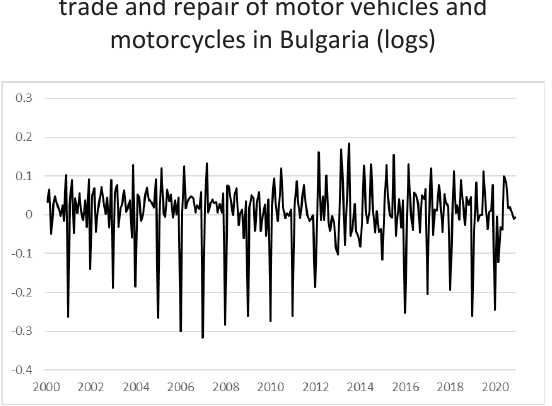
Figure A3. ACF for the turnover for wholesale and retail trade and repair of motor vehicles and motorcycles in Bulgaria (logs)